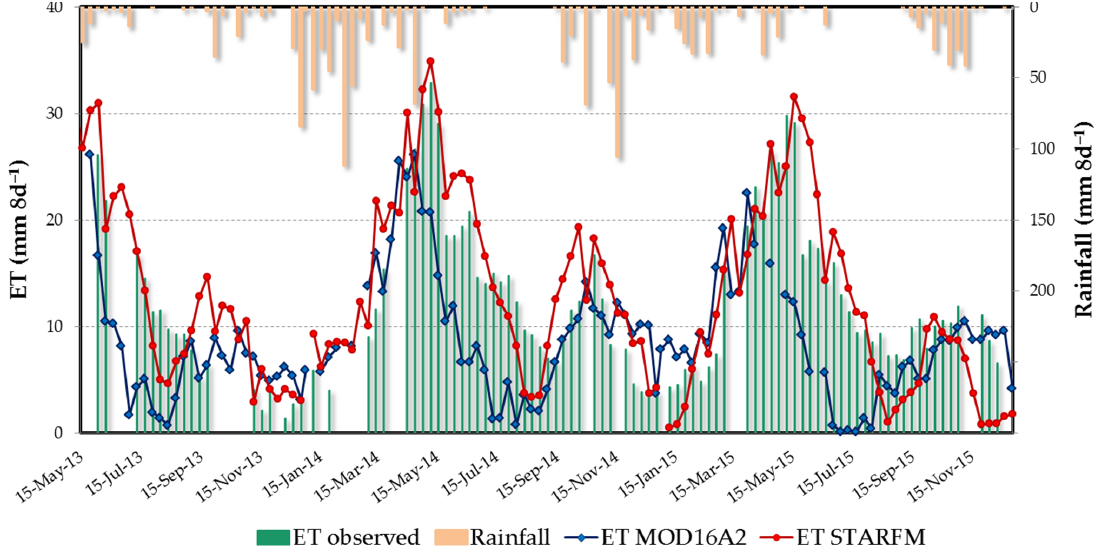
Figure 6. Comparison between observed, modeled by STARFM and MOD16A2 product ET for 2013–2015. Burnt orange bars illustrate rainfall events.